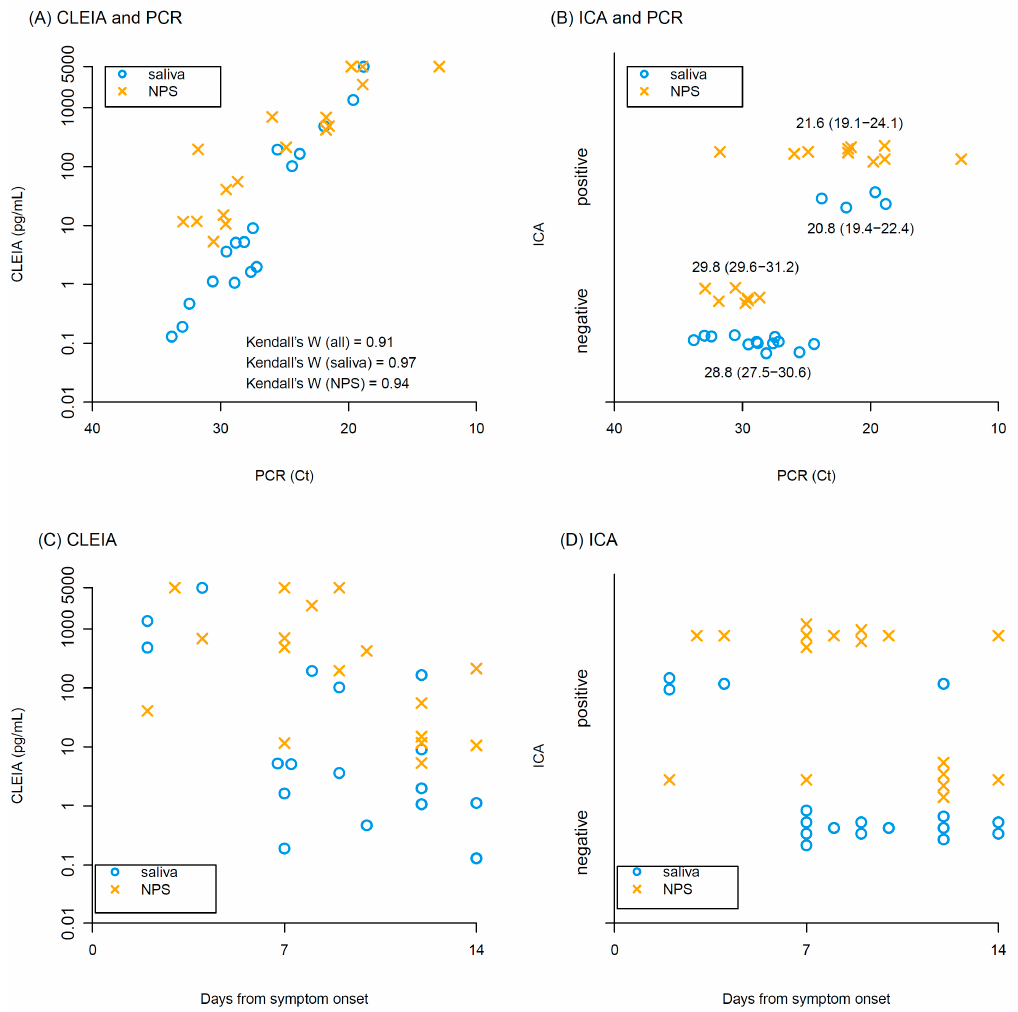
Figure 1. Results of CLEIA and ICA. Relationships between ( A ) antigen concentrations of CLEIA and Ct values of PCR, and ( B ) ICA positivity/negativity and Ct values of PCR. Median and interquartile range of Ct values are shown in ( B ). Relationship between days from symptom onset and ( C ) antigen concentrations of CLEIA, ( D ) Ct values of PCR. Blue circles and yellow crosses represent saliva and NPS samples, respectively.